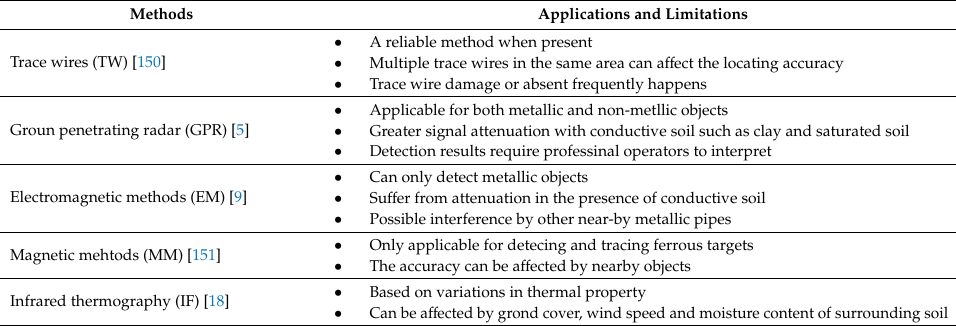
Table 4. Applications and limitations of di ff erent non-acoustic localization technologies.